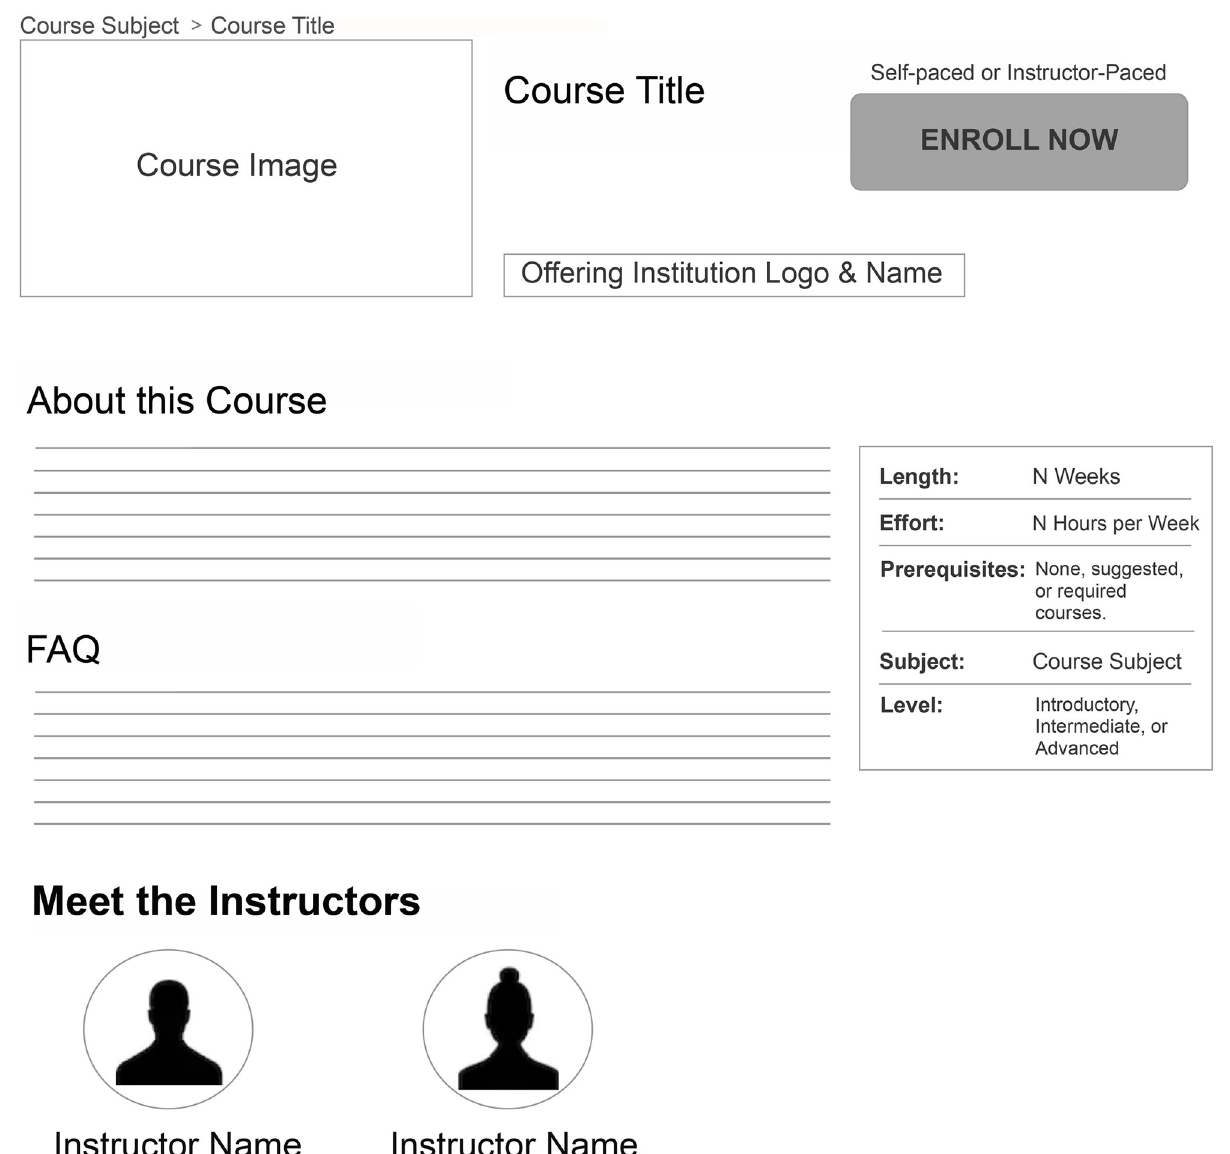
Fig 1. Schematic representation of a course enrollment page. A wireframe illustration of a course enrollment page highlighting key features that were coded.